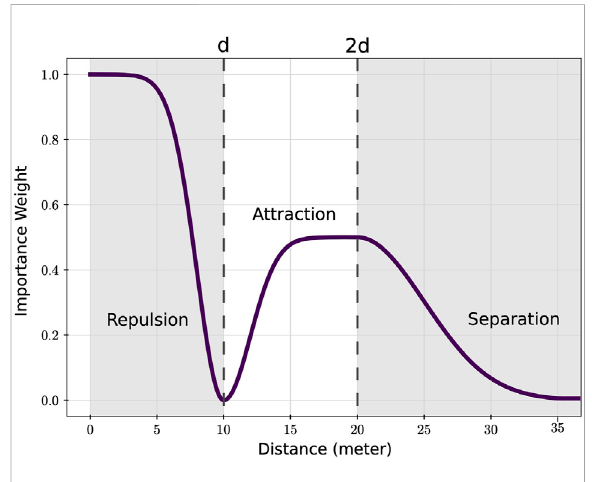
FIGURE 2 Gaussian mixture in Eq. 2 used to compute the importance weight. The three highlighted regions in the plot identify different rolesoftheimportanceweightfunction.Parameter d isthedesired distance of the focal robot from the interest